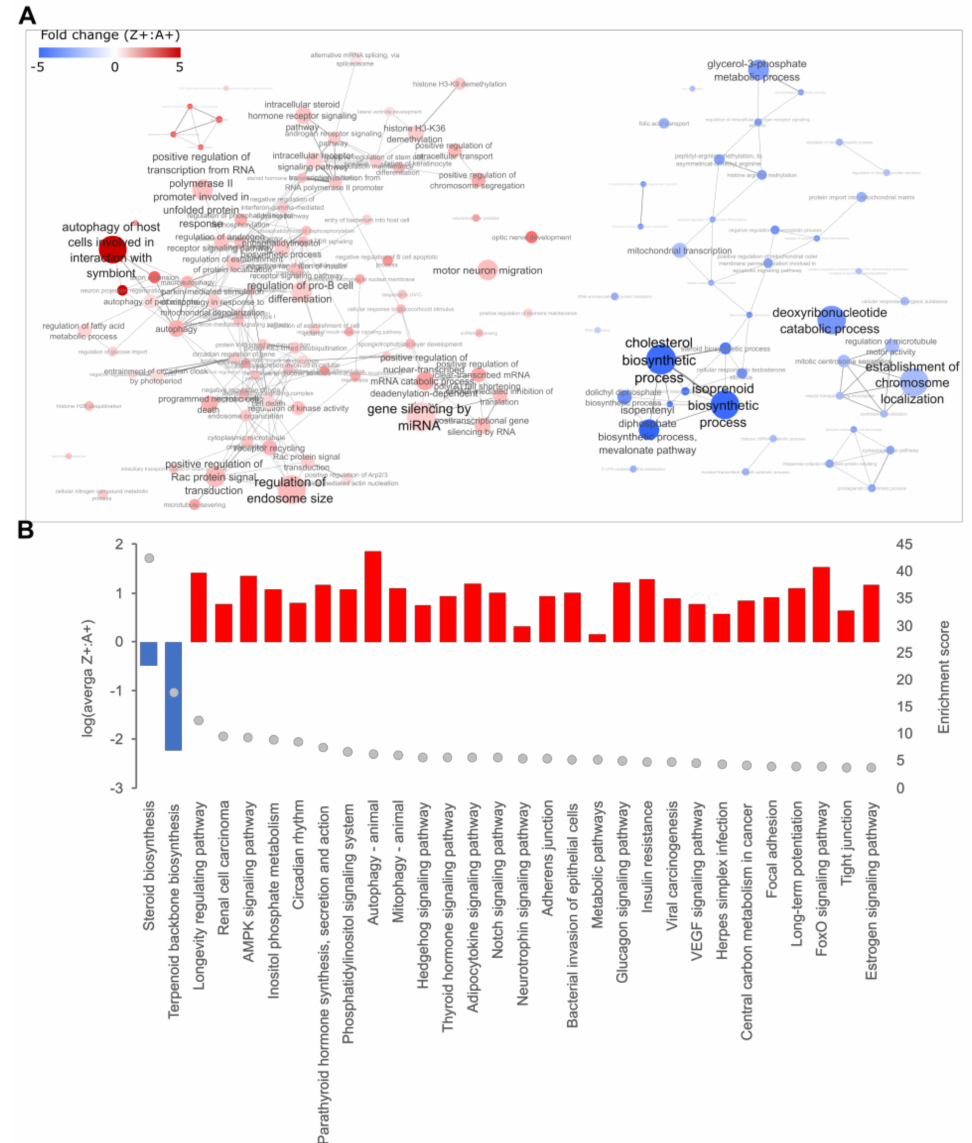
Figure 2. Pathway enrichment analysis of DEGs identified from RNA-seq data. Differentially expressed genes (DEGs) from RNA-seq data were mapped to the corresponding human orthologs and ( A ) Gene Ontology (GO) enrichment analysis was performed. The enriched GO annotations under the ‘Biological Process’ category were filtered based on an enrichment threshold >4 with annotations containing DEGs that are either all up- or down-regulated. Filtered annotations were then mapped onto an interaction network as nodes and were connected by an edge if there were common DEGs present between nodes. The thickness of the edge correlates to the number of common DEGs shared between two nodes. The size of each node represents the enrichment score from the GO enrichment analysis. Red indicates the up-regulation of the GO term while blue indicates downregulation. ( B ) The top 30 results from KEGG enrichment analysis. The histogram shows the direction and average level of dysregulation for all DEGs mapped to each KEGG pathway (left y -axis), and the grey dots indicate enrichment levels (right y